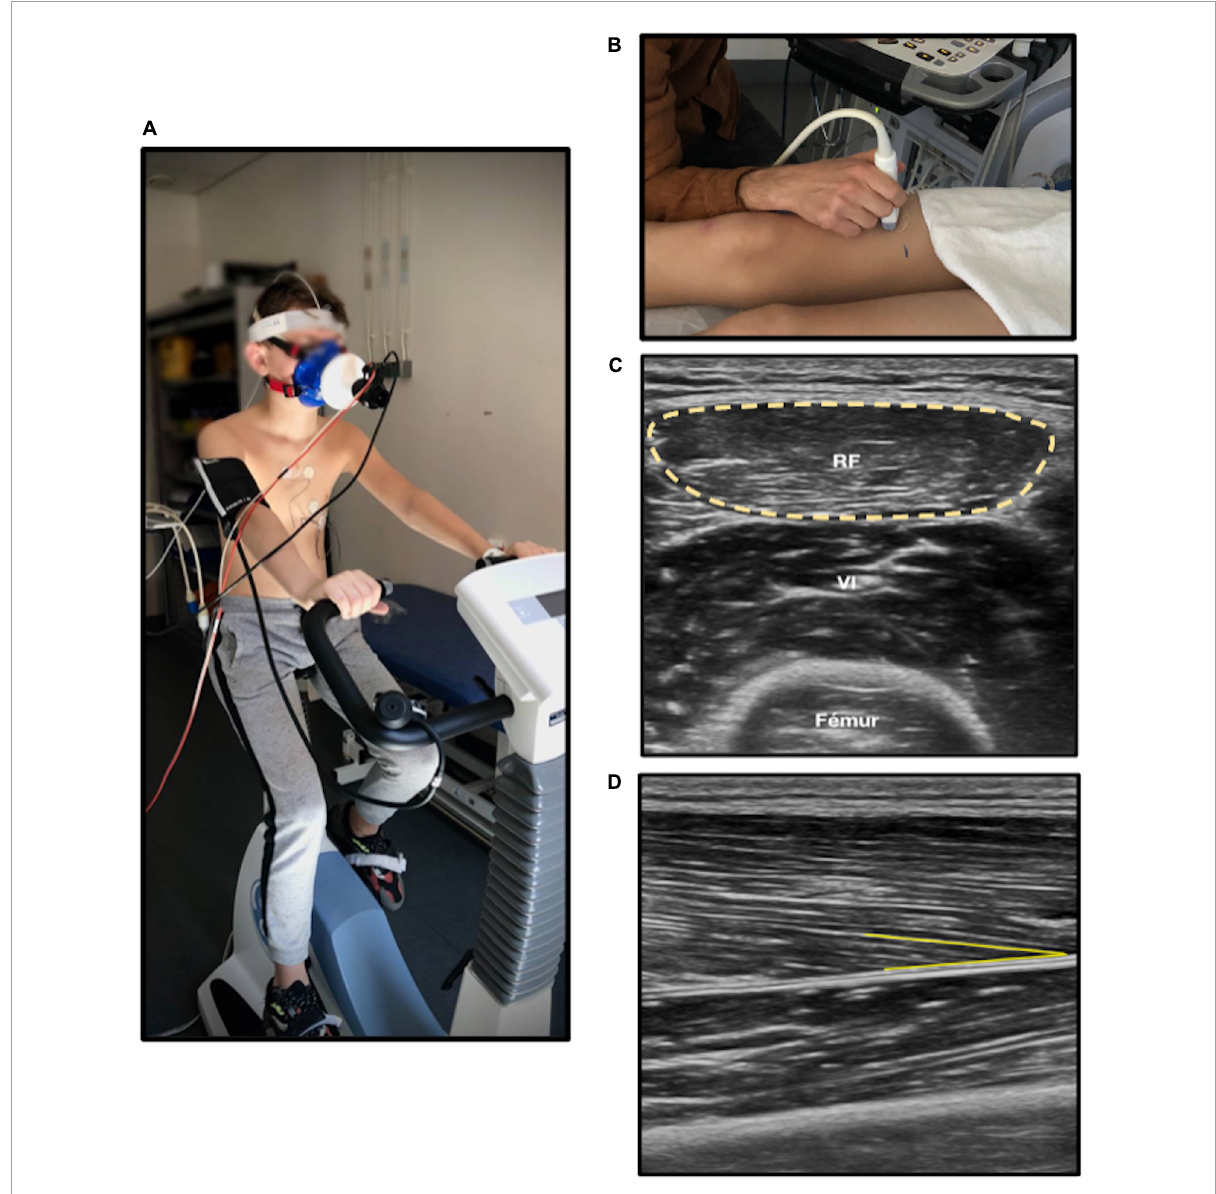
FIGURE1 Cardiorespiratory and muscle fitness analysis. (A) Cardiopulmonary exercise test on ergocycle. (B) Muscular ultrasound on right leg. (C) Anatomical cross-sectional area (yellow circle) of rectus femoris measured with ultrasound. (D) Pennation angle (yellow line) of right vastus lateralis; RF, Rectus femoris. The chosen anatomic site was at two third of the length from iliac spine anterior superior to upper edge of the patella on right leg. The probe was put in transversal plane and longitudinal plane for cross-sectional area and pennation angle,